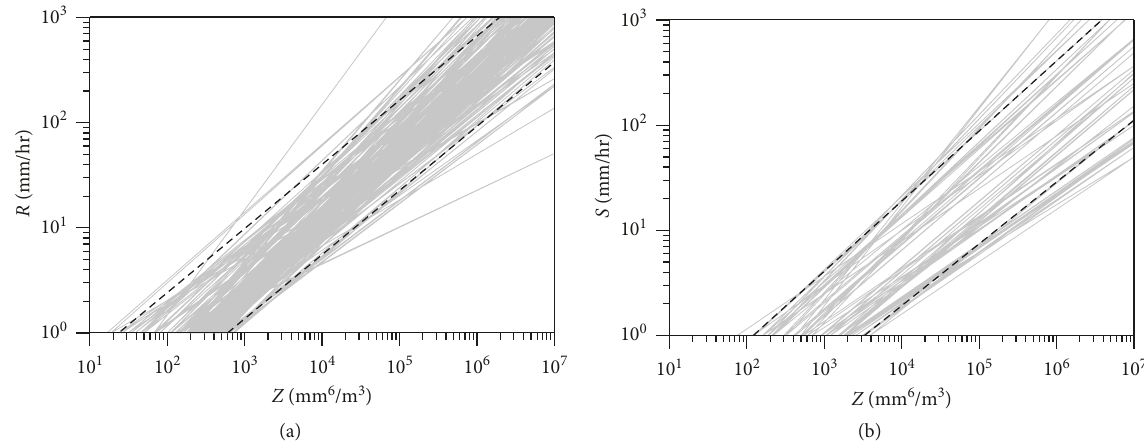
Figure 2: 95% confidence intervals derived for the (a) Z - R and (b) Z - S relationships.